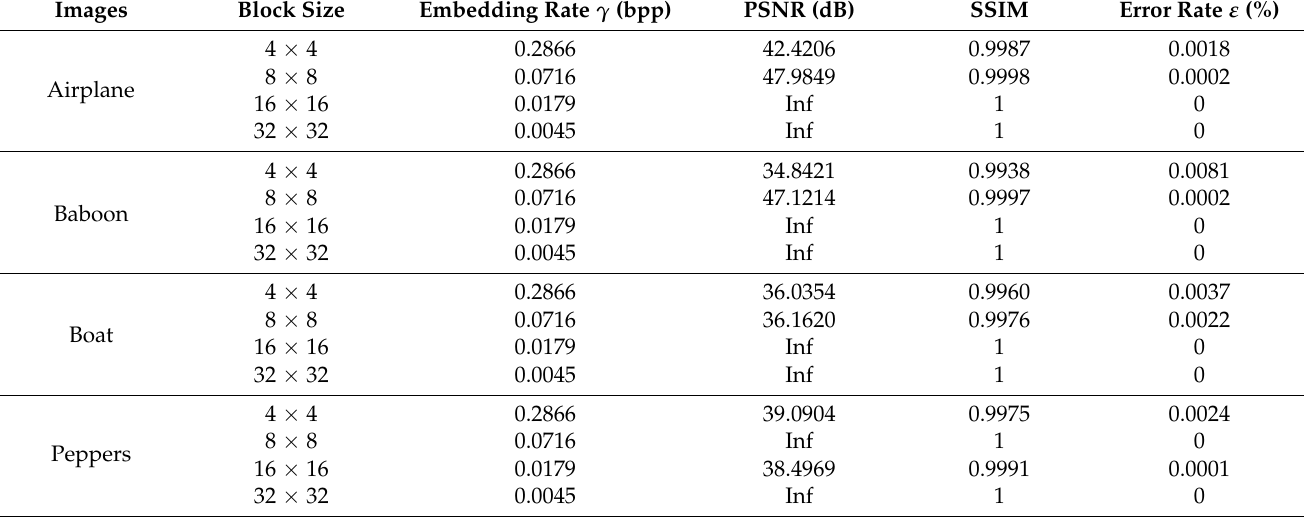
Table 2. Performances when number of sub-blocks = 4 and codebook size = 128.